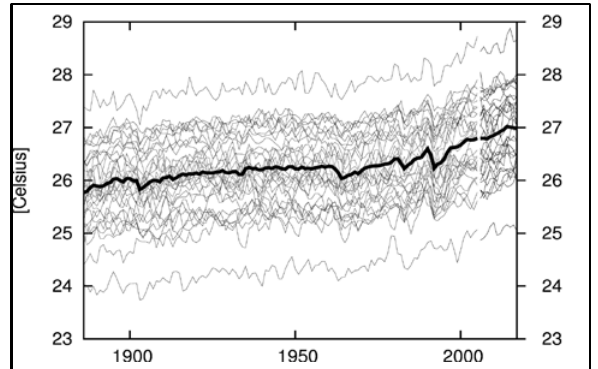
Figure 5. Atlantic SST in the ACR from 1886 to 2017 (January- December). Thin lines represent the CMIP5 RCP2.6 models, and the Models Yearly Mean (MYM) is represented with a thick black